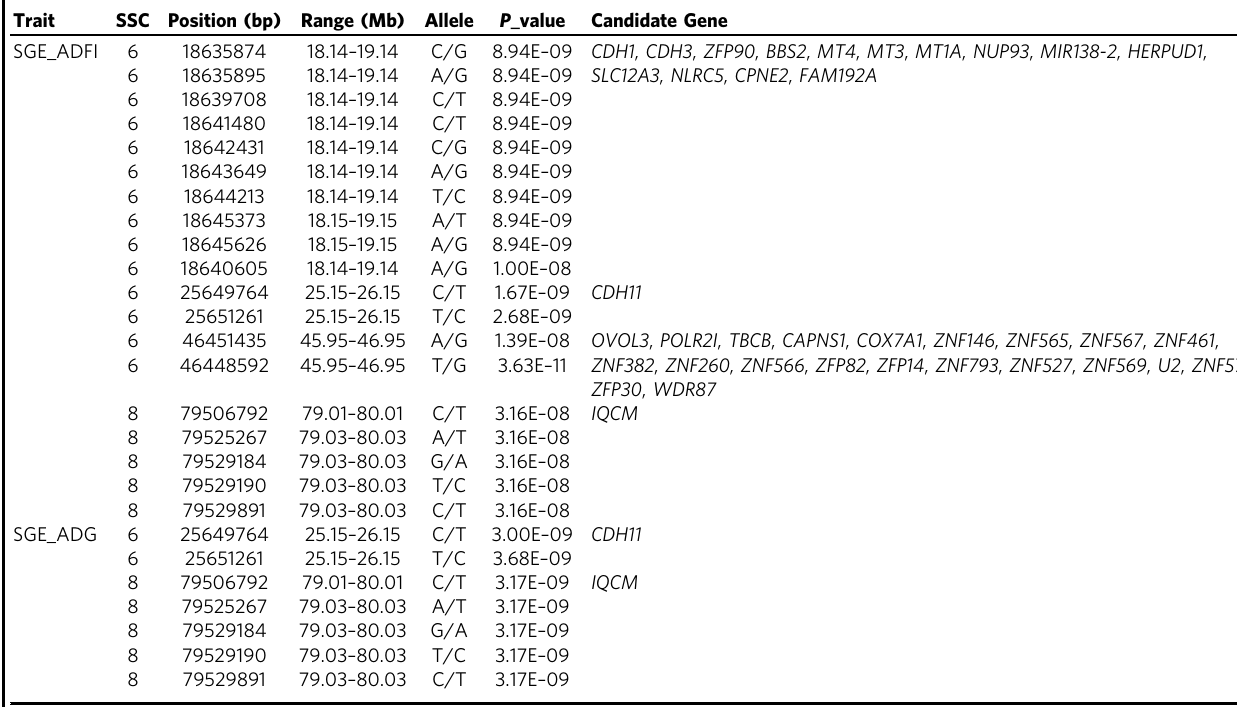
Table 4 Single-locus GWAS for social genetic effects (SGE) in Yorkshire pigs. Trait SSC Position (bp) Range (Mb) Allele